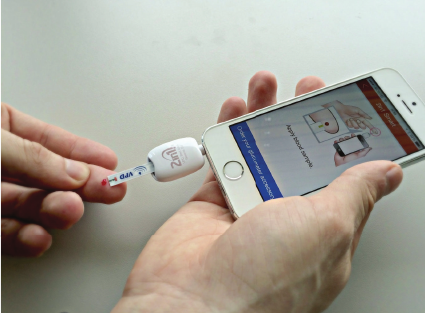
Figure 1: Performing the blood glucose